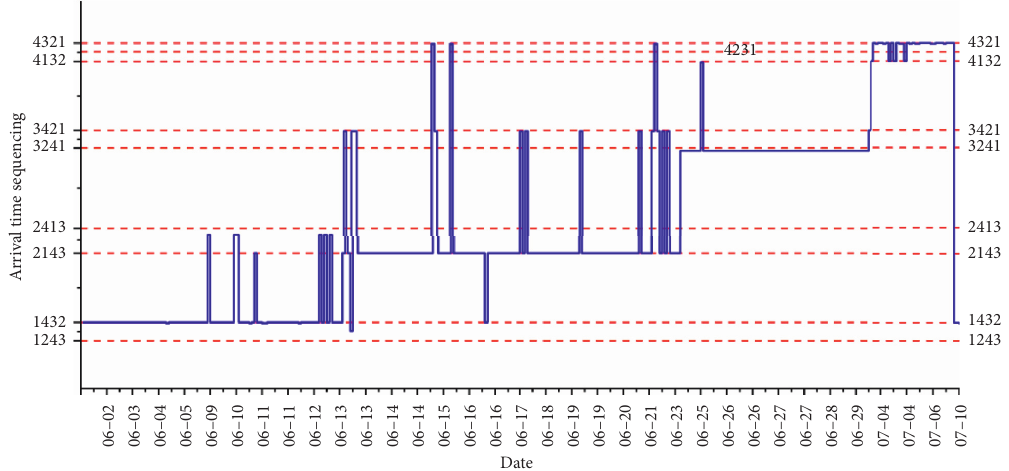
Figure 5: Arrival time sequencing of sensors in statistical